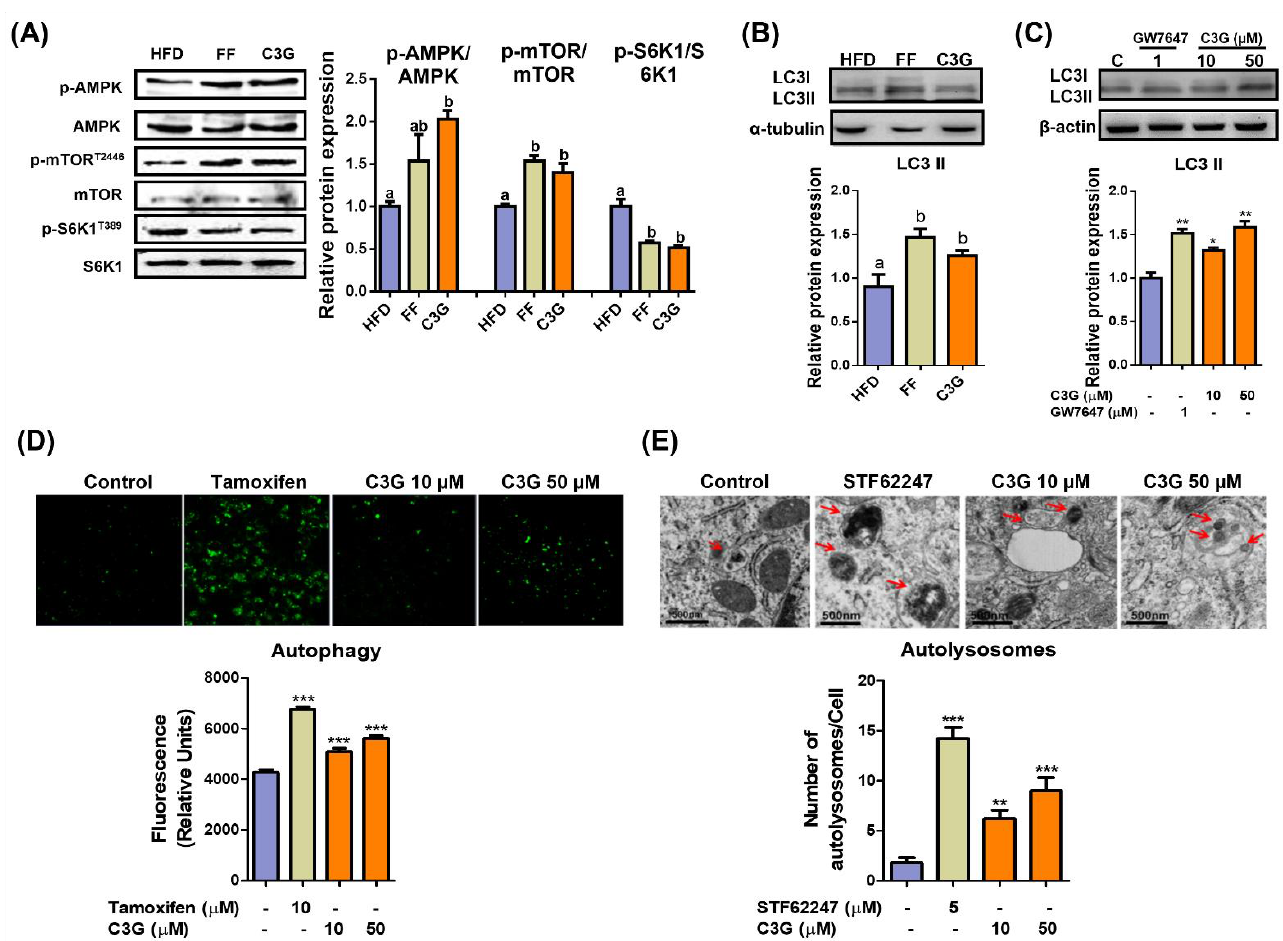
Figure 2. C3G activates hepatic autophagy via the AMPK-mTOR signaling pathway. ( A ) C3G stim- ulated AMPK, mTOR and S6K1 phosphorylation in the livers of mice in the HFD, fenofibrate (FF) and C3G groups. ( B , C ) LC3-II expression in mouse livers and HepG2 cells, respectively. GW7647 is a highly selective PPARα agonist. ( D ) MDC fluorescence staining for autophagy in HepG2 cells treated with tamoxifen and C3G. ( E ) Analysis of hepatic autolysosomes in HepG2 cells treated with STF62247 (a small molecule agonist that induces autophagy, and C3G using TEM). For comparisons between two groups, Student’s t -test was performed. *, p < 0.05; **, p < 0.01; ***, p < 0.005 compared with controls.